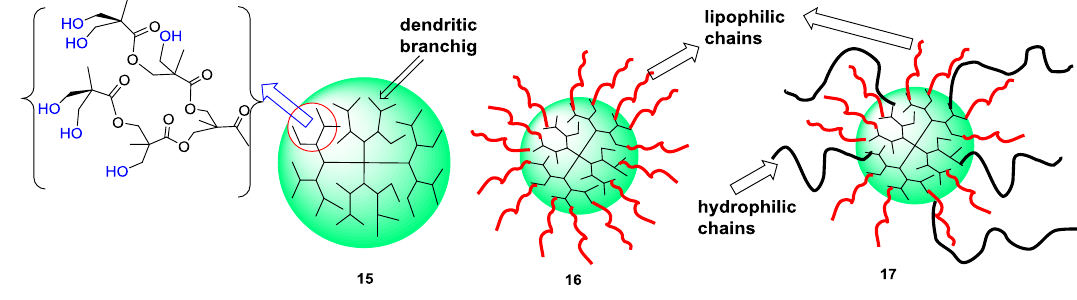
Figure 6. Schematic illustration of the Boltorn series: ( 15 ) Boltorn H40; ( 16 ) Boltorn U3000; and ( 17 ) Boltorn W3000 [197].